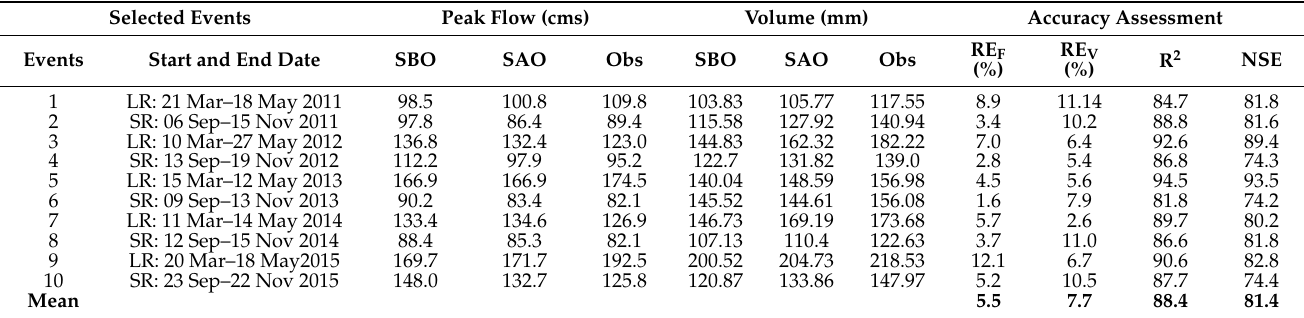
Table 4. Observed and simulated peak flow/volume before and after